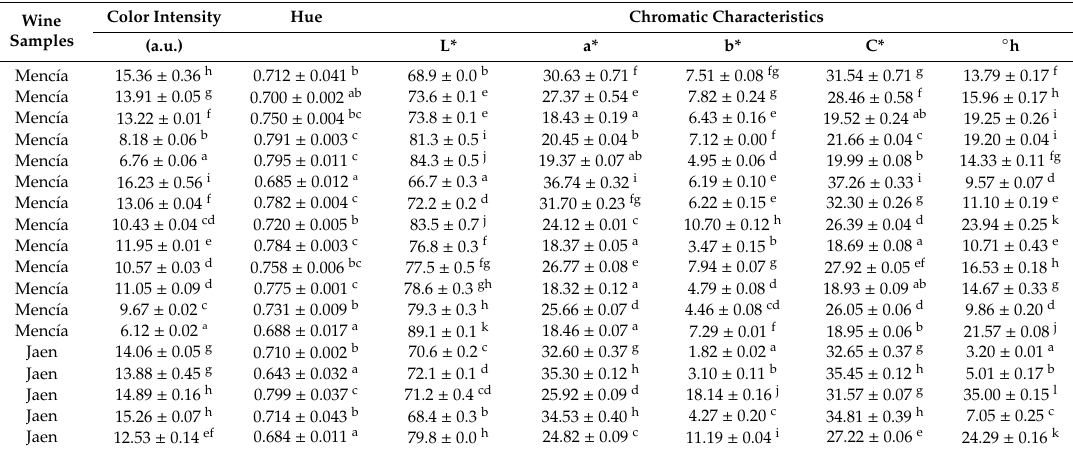
Table 4. ‘Menc í a’ and ‘Jaen’ red wines chromatic